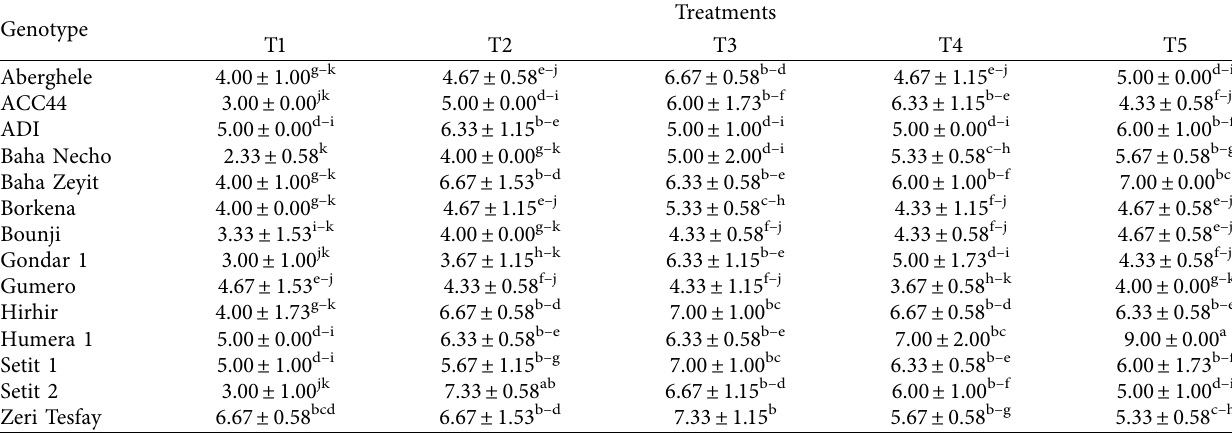
Table 4: The interaction effects of PGRs supplements and genotypes on the mean shoot